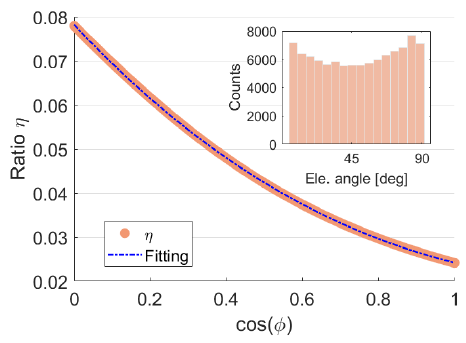
Figure A2. The relationship between geocentric angles ϕ and distance ratio η . In this simulation, 100,000 events were involved, and a histogram plot of the elevation angle is shown in the top right corner.